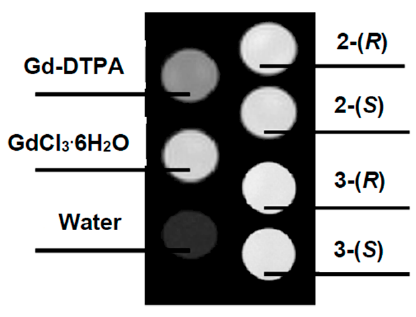
Figure 2. T 1 -weighted MR images of Gd-DTPA, GdCl 3 . 6H 2 O, 2 -( R ), 2 -( S ), 3 -( R ), 3 -( S ), (0.25 mmol/L) and water (Spin echo from TR/TE 200/6.2 ms, 7 T, 20 °C). Table 1. Longitudinal relaxivities ( r 1 ) of Gd-DTPA, 2- ( R ), 2- ( S ), 3 -( R ) and 3 -( S ).